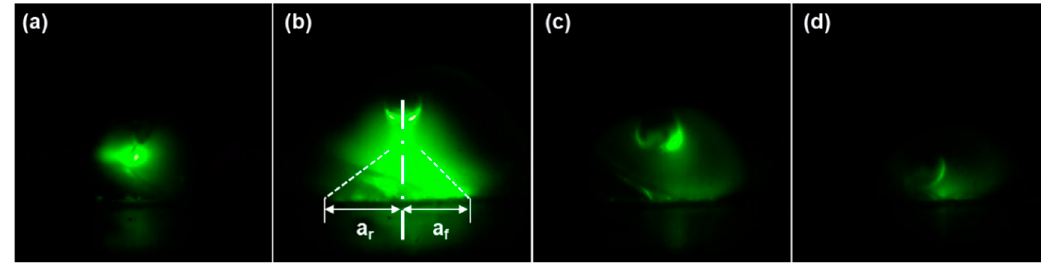
Figure 2. Evolution of the arc captured with a high-speed camera during once cycle (17.25 ms from ( a ) to ( d )) of the CMT-based WAAM process.